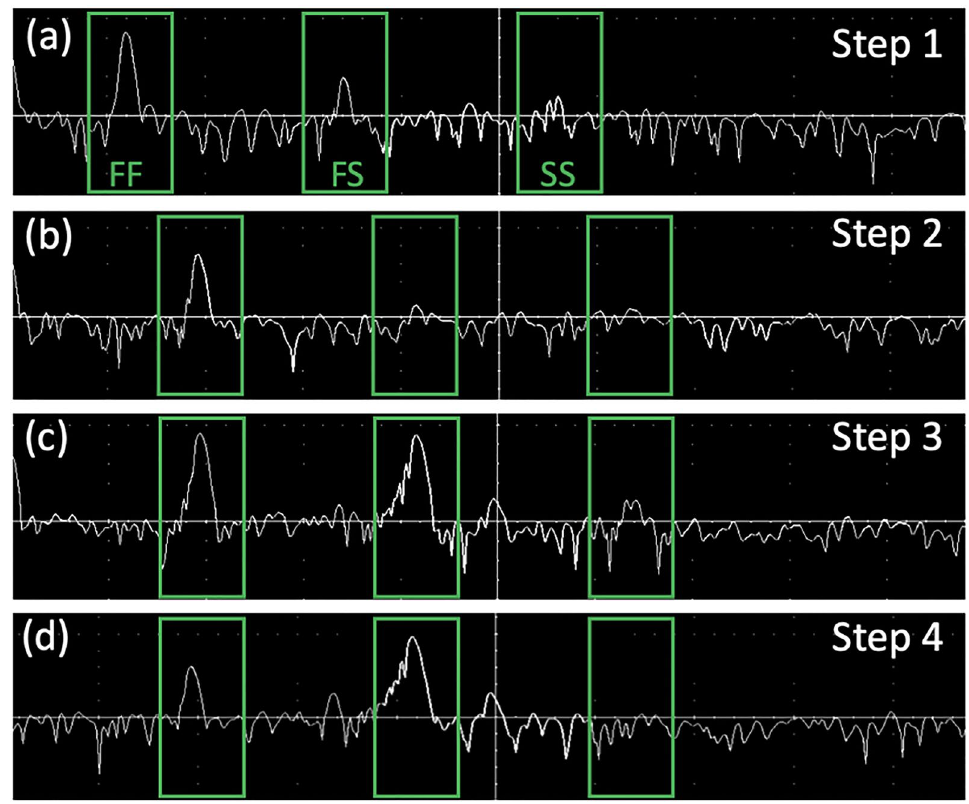
Figure 7. A-line signal from the pre-operational setup procedure of microscopic PSOCT at each step. ( a ) Step 1. ( b ) Step 2. ( c ) Step 3. ( d ) Step